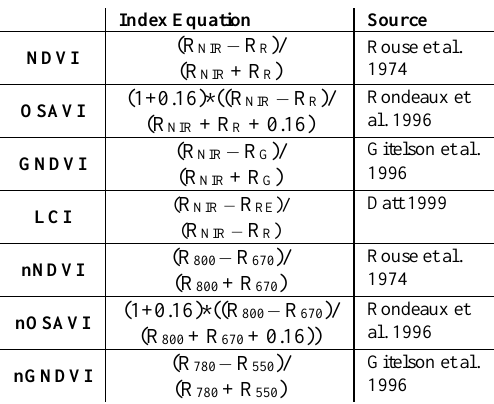
Table 1. Vegetation Indices from spectroradiometer measurements analysed in this study. R = reflectance (%), R R = red, R G = green, R RE = Red Edge, R NIR = near- infrared, R i = reflectance in narrow band region (R 670 = 670 nm). Lower case n denotes narrow band index.